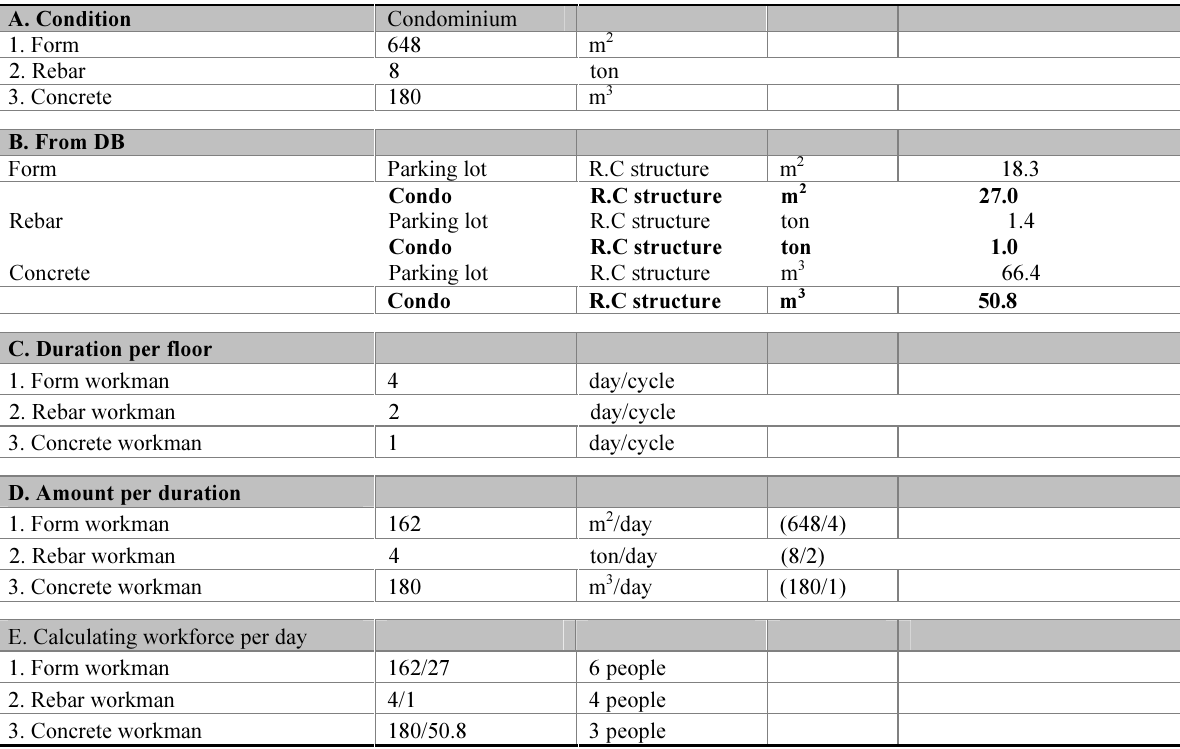
Table 2. Calculating production